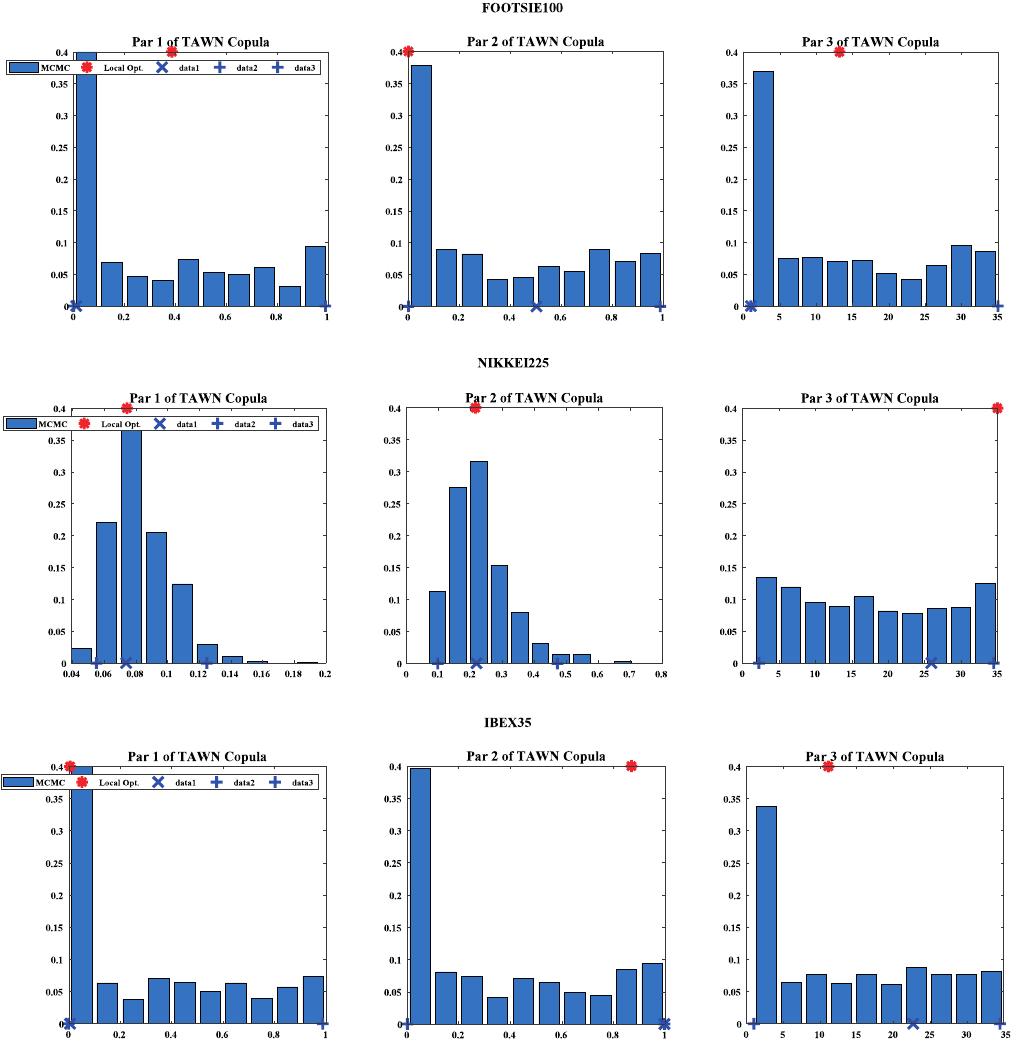
Figure 4. Posterior distribution of fitted Tawn’s copula on FOOTSIE100, NIKKEI225, and IBEX35 indices obtained by the MCMCS. Source: Own